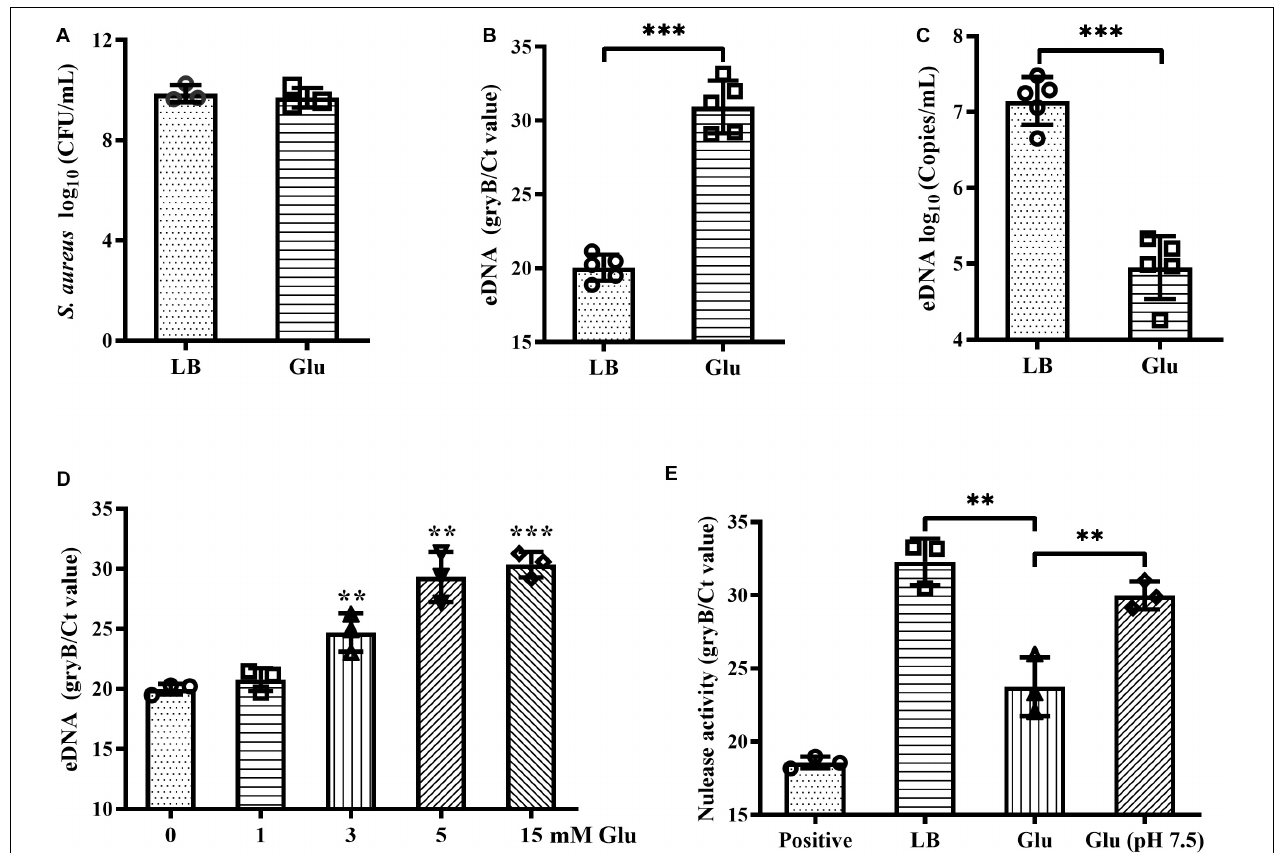
FIGURE 1 | Glucose reduced eDNA levels of S. aureus biofilms. (A) CFUs of biofilms of S. aureus Newman cultured in LB medium with or without 15 mM glucose for 18 h. Supernatants were carefully removed, biofilms were harvested by resuspended in 500 µ L TE buffer, and the CFUs of the biofilms were determined. (B) eDNA of biofilms quantified by real-time PCR targeting the gene gyrB . (C) eDNA of biofilms quantified using a commercialized PCR-based detection kit. (D) eDNA of biofilms of S. aureus Newman cultured in LB medium supplemented with 0, 1, 3, 5, or 15 mM glucose for 18 h. (E) Quantification of gDNA remaining after co-culture of gDNA solution with biofilm supernatants for 30 min; gDNA was quantified by real-time PCR targeting gyrB . ∗∗ p < 0.01; ∗∗∗ p < 0.001.